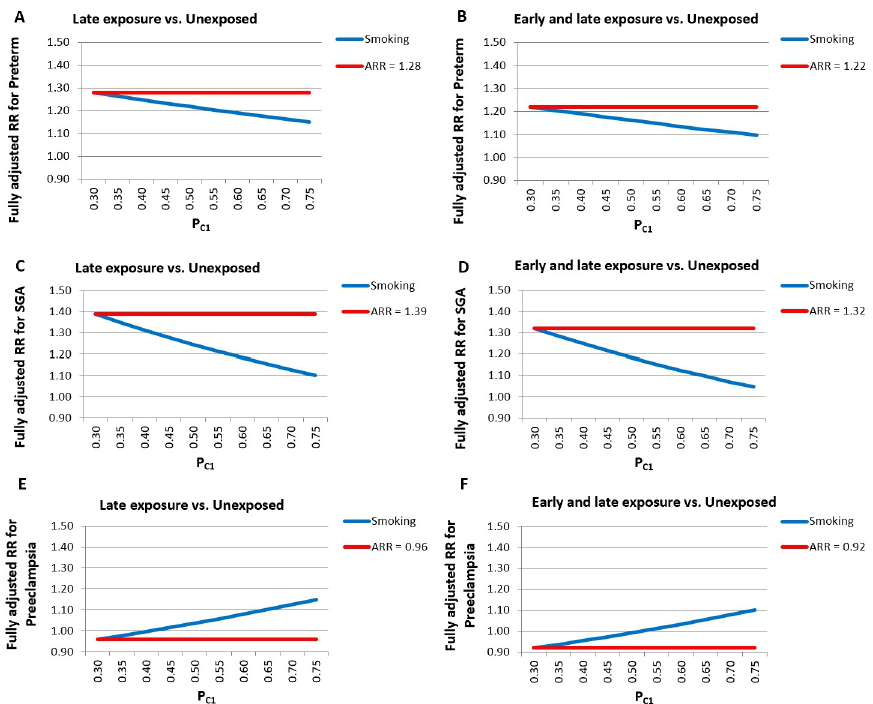
Fig 2. Bias analysis quantifying the impact on point estimates of increasing residual differences in the prevalence of maternal smoking between unexposed and gabapentin-exposed women either late (A, C, E) or both early and late in pregnancy (B, D, F). ARR, apparent relative risk; P C1 , prevalence of maternal smoking among exposed women; RR, relative risk; SGA, small for gestational